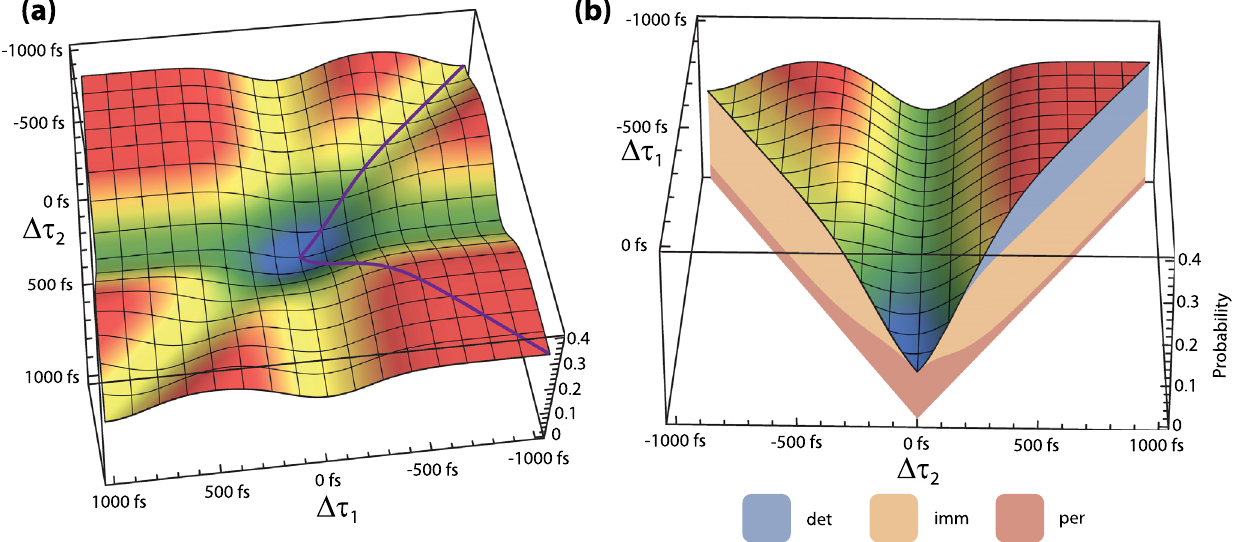
FIG. 1. The coincidence landscape and its substructure. (a) Coincidence landscape which is the visual representation of the nonclassical interference of three photons of tunable distinguishability. (b) Cut along the diagonal and antidiagonal lines of pairwise delays Δ τ 1 ¼ Δ τ 2 and Δ τ 1 ¼ − Δ τ 2 , also indicated as a purple trajectory in (a). The height of the landscape corresponds to the coincidence output probability of a three-photon scattering event. The substructure, expressed in terms of contributions from the permanent “ per ” , the determinant “ det ” , and immanants “ imm ” , reveals the nature of the scattering event. Beside the plateaux (color coded in red), which can be explained classically, the whole landscape is governed by a genuine quantum interference of the